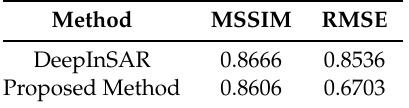
Table 4. Quantitative indexes of the proposed method and DeepInSAR.